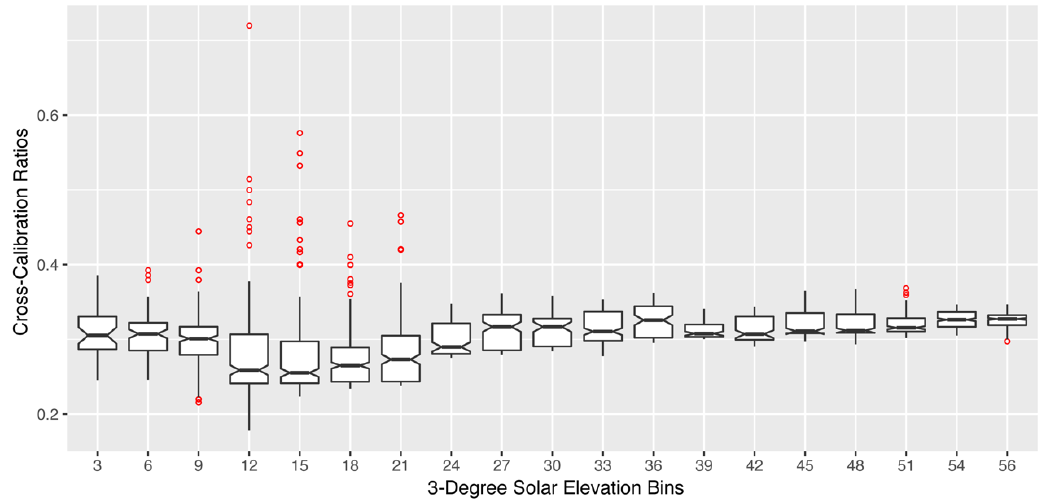
Figure 3. Boxplot distribution of diurnal cross-calibration ratios for the 532 nm SRS-PRI fore-optic. Each boxplot represents a 3° solar elevation bin. Red points represent outliers and were observed more often in low solar elevation bins.